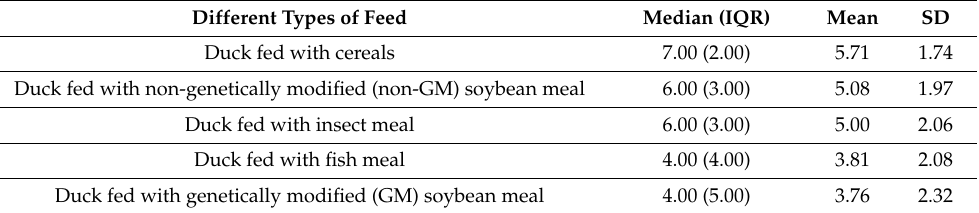
Table 1. Willingness to purchase duck fed with different feed sources 1 .